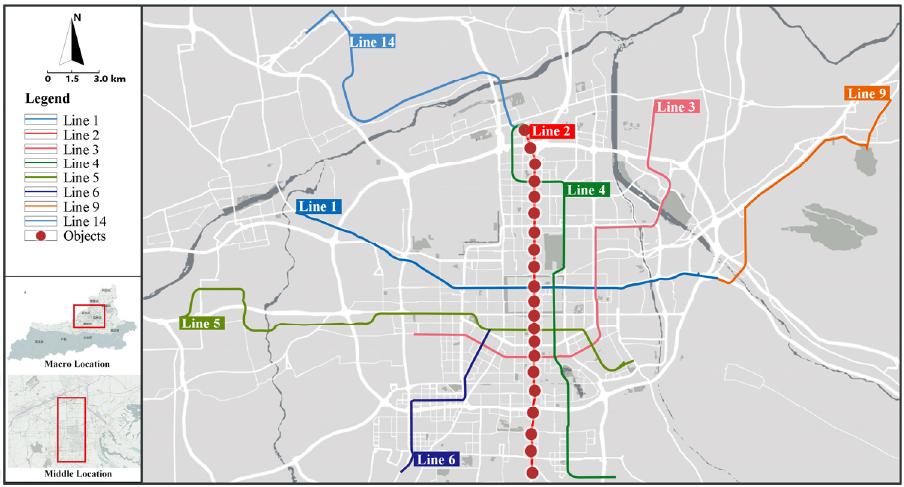
Figure 1. Station location schematic.